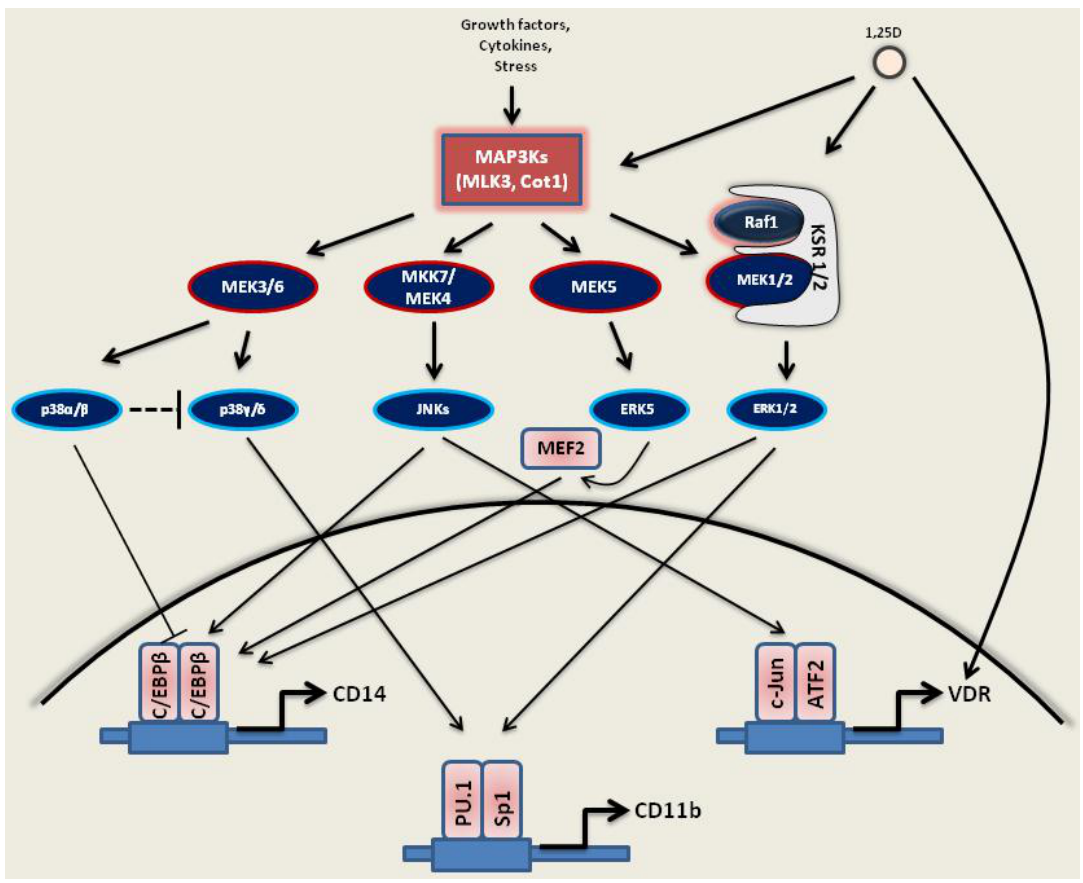
Figure 3. 1,25D’s influence on MAPK